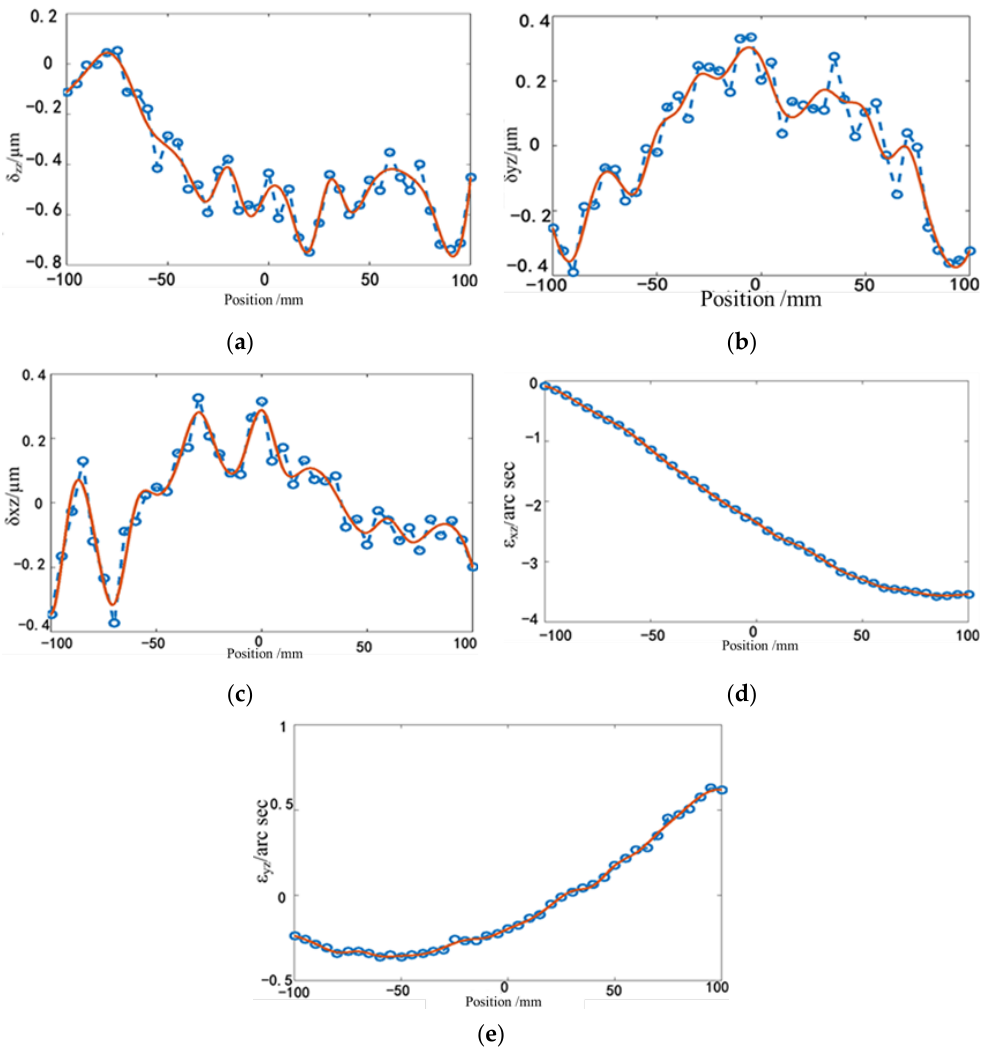
Figure 10. Geometric errors for the Z − axis. ( a ) Linear displacement error δ zz (z) for the Z − axis; ( b ) Straightness error in the Y direction δ yz (z) for the Z − axis. ( c ) Straightness error in the X direction δ xz (z) for the Z − axis. ( d ) Yaw angle error ε xz (z) for the Z − axis. ( e ) Pitch angle error ε yz (Z) for the Z − axis. The rotation displacement error and fitted results for the B − axis can be seen in Figure 11.